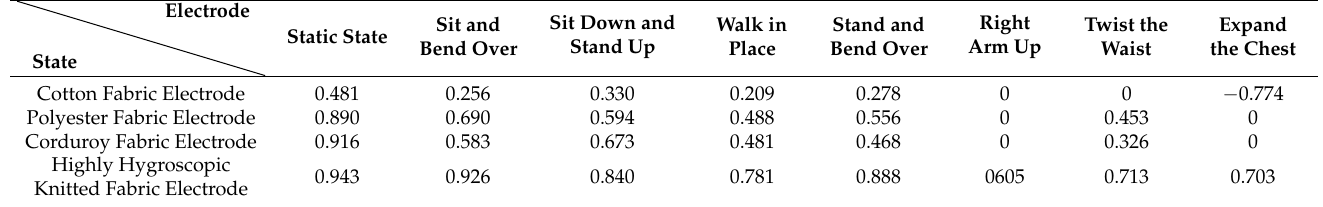
Table 1. The correlation coefficient between the ECG pattern corresponding to the four fabric electrodes and the disposable gel electrode.